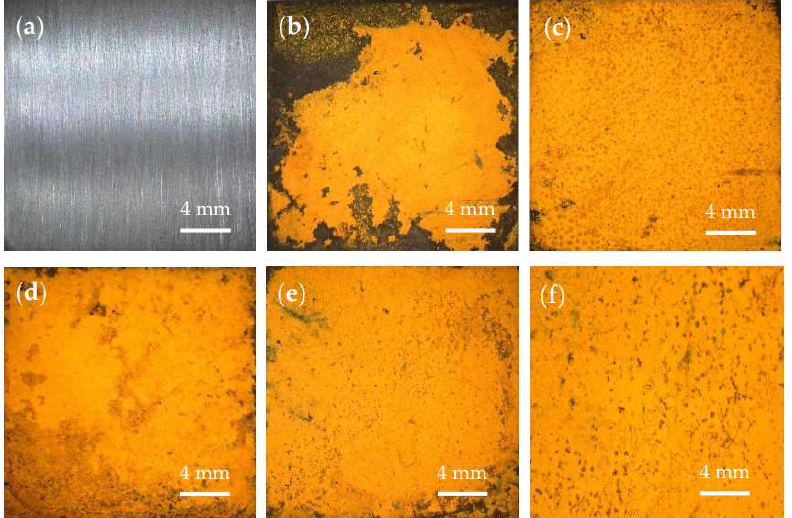
Figure 2. Macroscopic morphologies before and after corrosion test: ( a ) before corrosion test; ( b ) 48 h in 3.5% NaCl; ( c ) 144 h in 3.5% NaCl; ( d ) 288 h in 3.5% NaCl; ( e ) 144 h in 2.0% NaCl; and ( f ) 144 h in 5.0% NaCl.